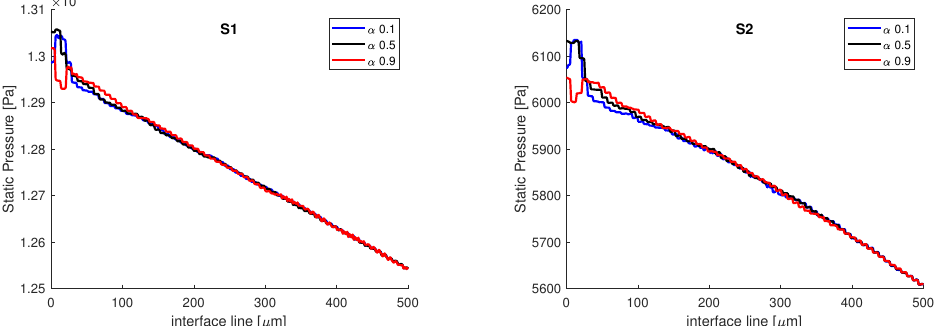
Figure 8. Static pressure variation on the interface lines at different volume fractions. The main differences are observed in the near vicinity of the junction.